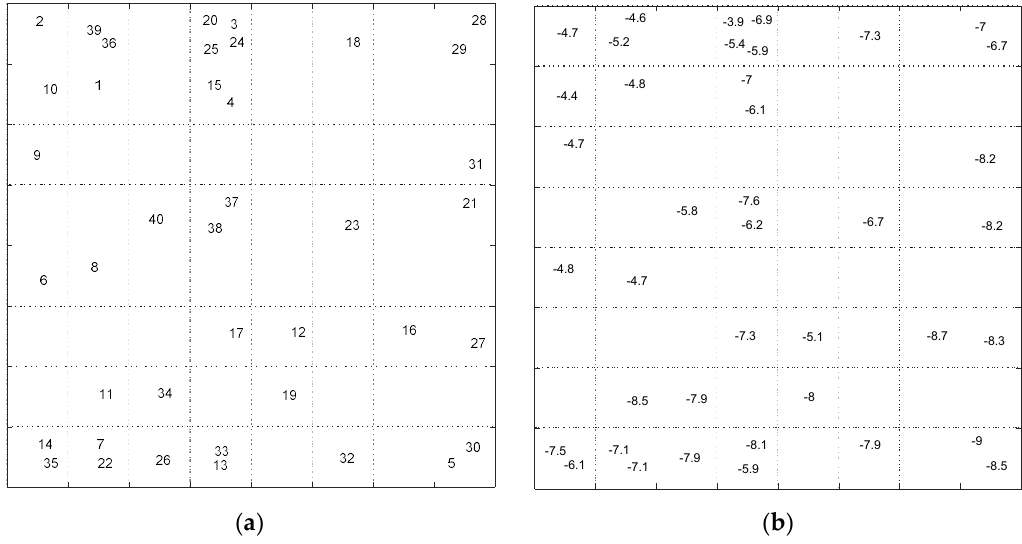
Figure 19. The Top-Map of SOM. ( a ) winner neurons for samples are labeled with compound number; ( b ) winner neurons are labeled with the docking score values.